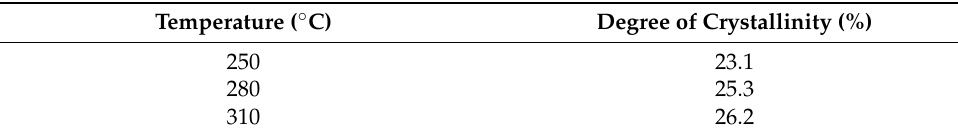
Figure 8. DSC curves for the CF/PPS composites (processing temperatures of 280 ◦ C): ( a ) 1st heating and ( b ) 1st cooling cycles. Table 3. Degree of crystallinity of the CF/PPS composites measured by